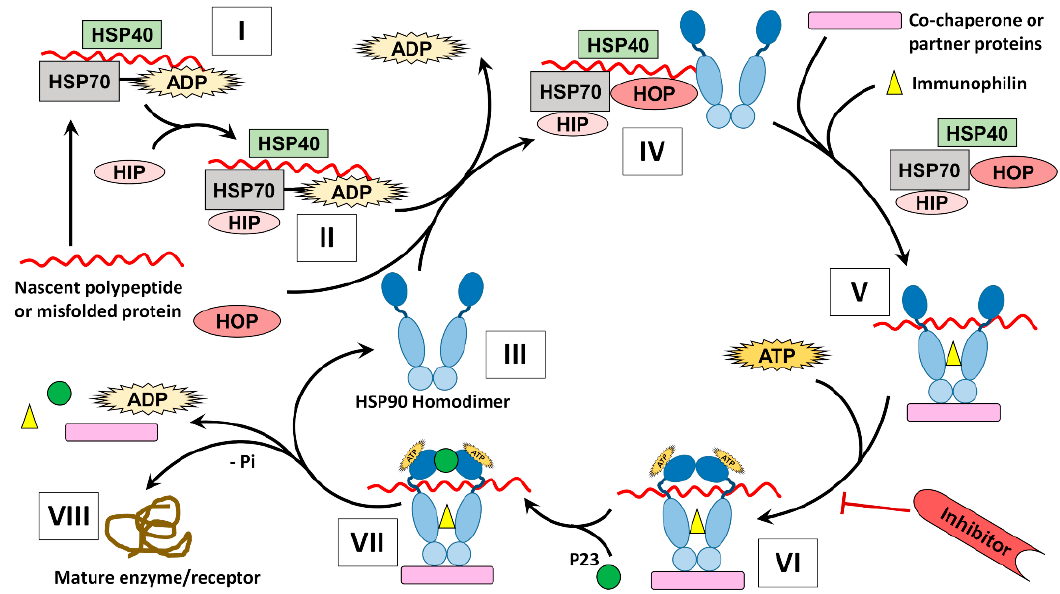
Figure 3. The mechanism of protein folding by HSP90 [44]. ( I ) The client protein either mis-folded protein or nascent polypeptide is bound by Hsp70/Hsp40/ADP complex to be protected from potential aggregation [102]; ( II ) The protein complex formed is further stabilized by Hsp70-interacting protein (HIP) or Bcl2 which support the change of ADP to ATP [103]; ( III ) HSP90 binds the client protein harboured by the Hsp70/Hsp40 protein complex to start its action; ( IV ) The interaction between HSP90 and HSP70 is facilitated by the adaptor protein, HOP/Sti1 (Hsp90–Hsp70 organizing protein) [104]. Importantly, additional co-chaperone known as Cdc37 (cell-division-cycle 37 homologue) or p50 is needed for loading client kinases onto HSP90 [105]; ( V ) As the client protein is loaded, other co-chaperones, immunophilins like (FKBP51, FKBP52) are added to the HSP90 homodimer forming an activated heteroprotein complex while the HSP70, HIP and HOP are released [106]; ( VI ) Binding of ATP to the NTD of HSP90 in the heteroprotein complex switches the HSP90 from the “open state” to the “closed state”[107]. Various inhibitors of HSP90 can act at this stage by competing with ATP for the NTD binding site consequently resulting in protein degradation by proteasome [101]; ( VII ) If no inhibitors interfere with the folding cycle, association of other co-chaperones occurs including p23 and Aha1 (activator of Hsp90 ATPase homologue 1); ( VIII ) Binding of Aha1, not shown in the diagram, to the MD of HSP90 induces ATP hydrolysis and supports folding of the bound client, as well as enhances the release of immunophilins and co-chaperones [96].